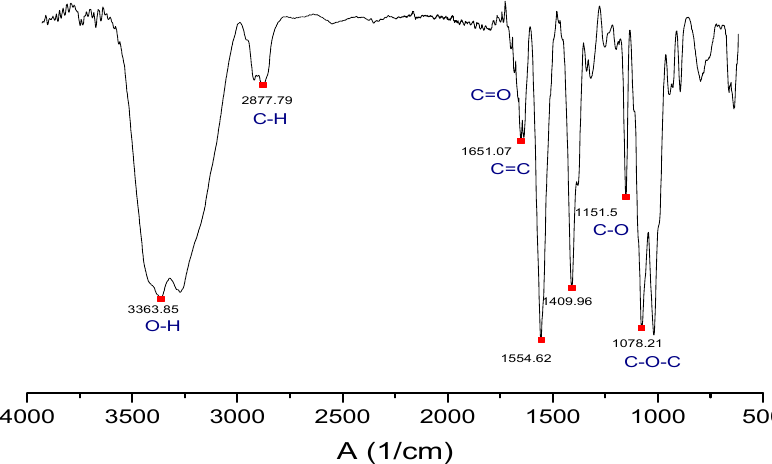
Figure 1. Fourier transform infrared spectroscopy (FTIR) spectrum of the graphene oxide (GO) synthesized in the study.